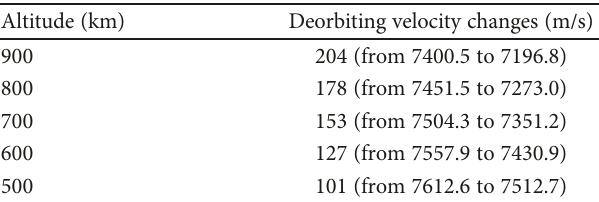
Table 2: The required velocity changes in di ff erent altitudes. Altitude (km) Deorbiting velocity changes